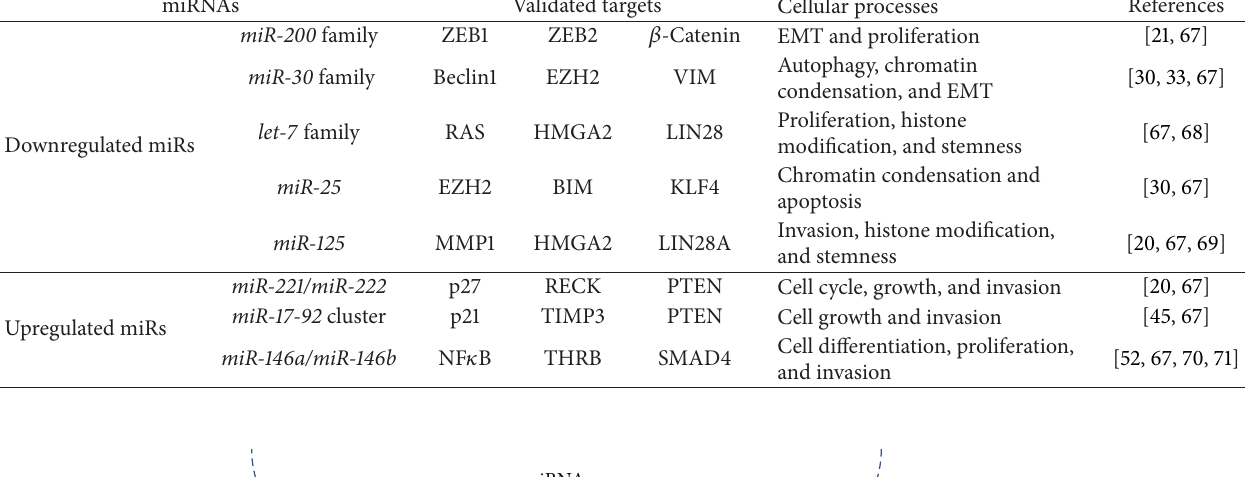
Table 1: Validated targets for deregulated miRNAs in ATC.